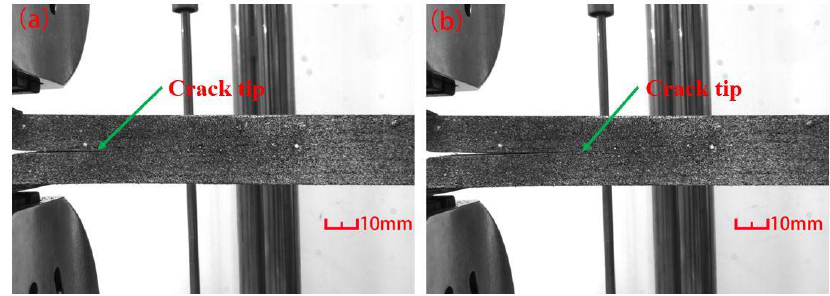
Figure 15. ( a ) DCB specimen before the formal test. ( b ) DCB specimen after the test.